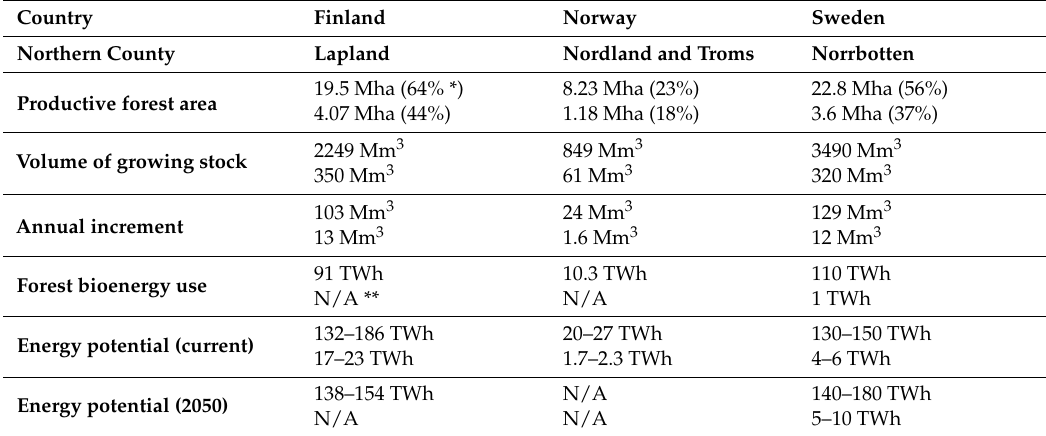
Table 8. Current and future ranges for woody biomass from forestry and forestry residues for energy use in Finland, Sweden and Norway and in the selected northern